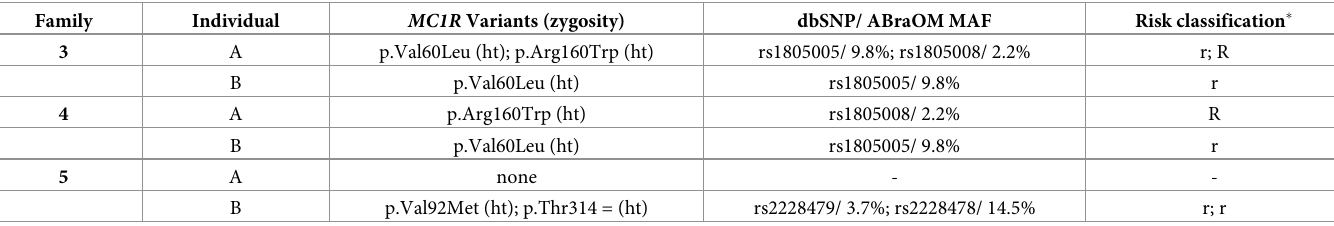
Table 2. Clinical characteristics of melanoma